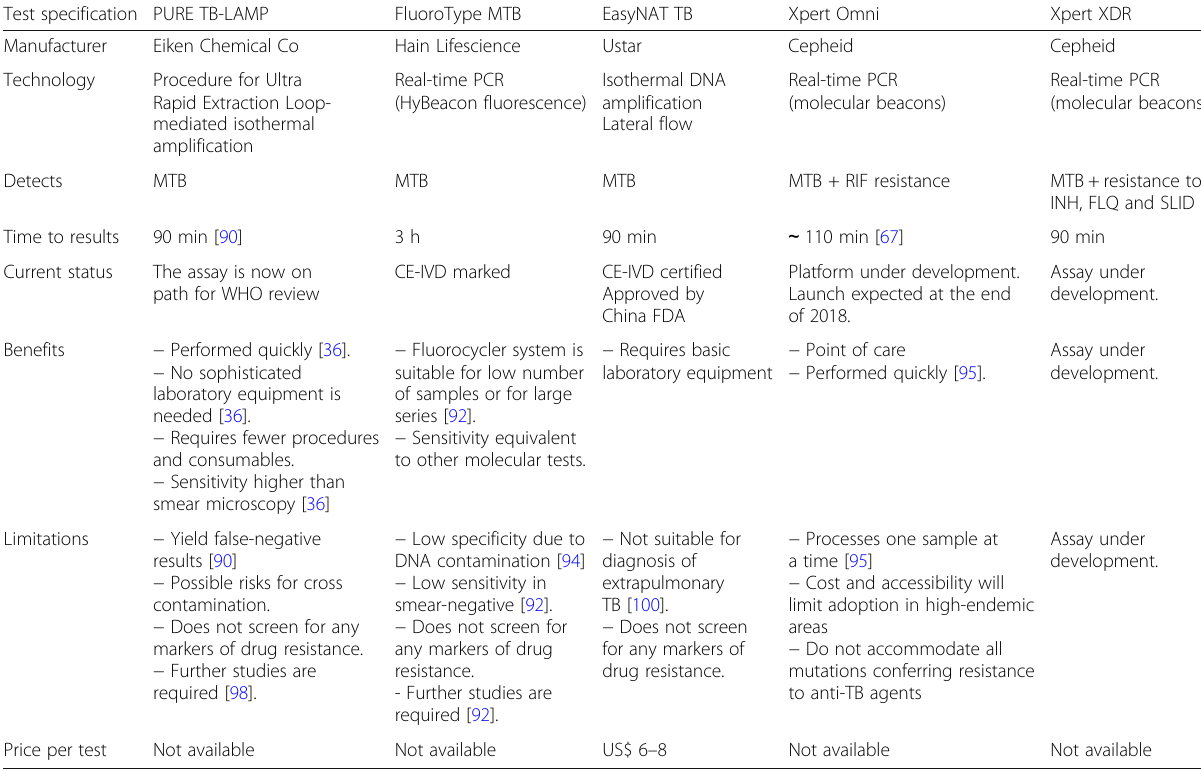
Table 3 characteristics of molecular assays for rapid detection of MTB and drug-resistance, not yet approved by WHO and/or